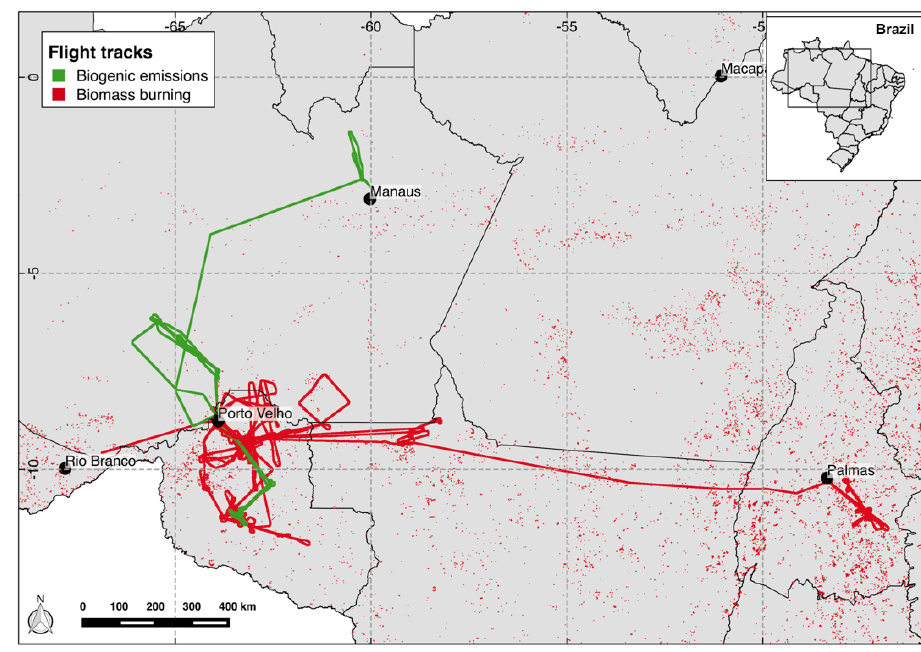
Figure 1. SAMBBA flights tracks according to their original goals as biogenic emissions (green) and biomass burning (red). The black dots indicate the locations of the taking-off and landing airports. The red points depict the fires detected by MODIS on board AQUA satellite during the SAMBBA campaign from 14 September to 3 October